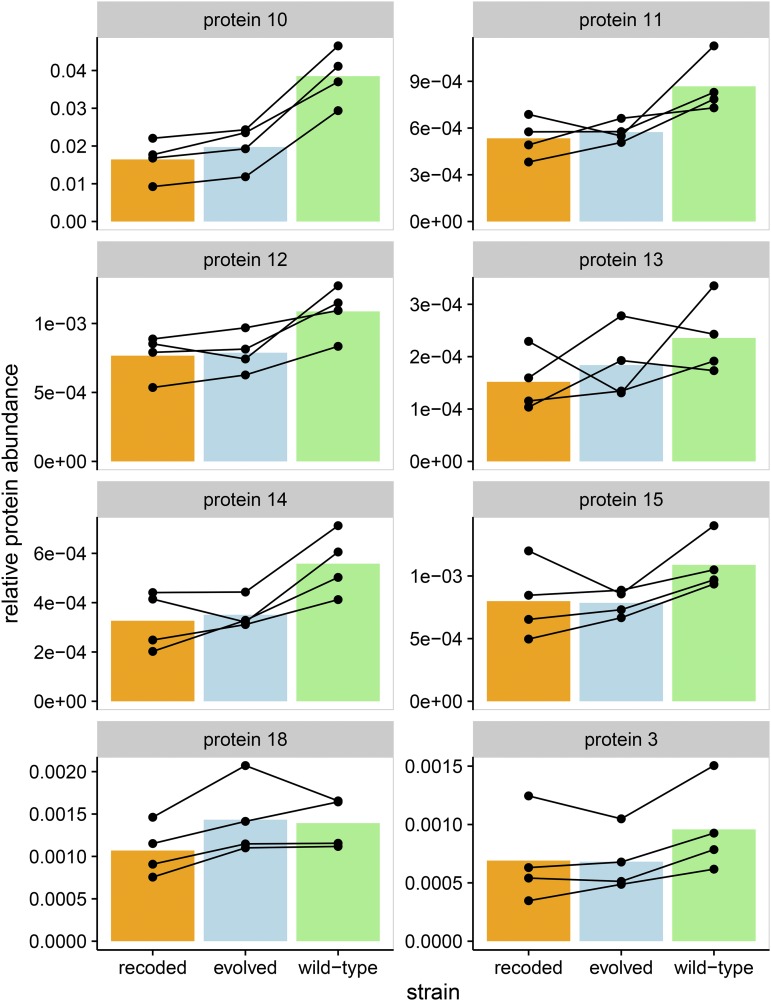
Recoding of gene 10 reduces abundances of capsid protein (gp10), of five other proteins encoded immediately downstream of 10 (gp11–15), and of T7 endonuclease (gp3). The bacteriophage T7 genome contains many polycistronic transcripts. Genes 11 and 12 are always transcribed with gene 10, following a read through of the Tϕ terminator. Genes 13, 14, and 15 may also share the same transcript as gene 10, although these will be less common because of an RNase cleavage site between genes 12 and 13, and a promoter before gene 13. The panels show the relative protein abundances corresponding to these genes, in addition to gene 3, for all wild-type, recoded, and evolved strains at the 9-min time point. All of these genes, with the exception of gene 3, are class-III genes, expressed late in the T7 life cycle. In addition to lower abundance of capsid protein (gp10), all protein products from the five genes immediately downstream of 10 are also suppressed (FDR<0.1, FDR-corrected paired t-test). These proteins are tail tubular proteins (gp11 and gp12), probable virion-associated protein (gp13), and two internal virion proteins (gp14 and gp15). Gene 3, which codes for the T7 endonuclease, also has a reduced abundance in the recoded strain. Protein abundances for the evolved strain fall somewhere between that of the wild-type and the recoded strains. Each point represents a single measurement, and lines connect biological replicates.